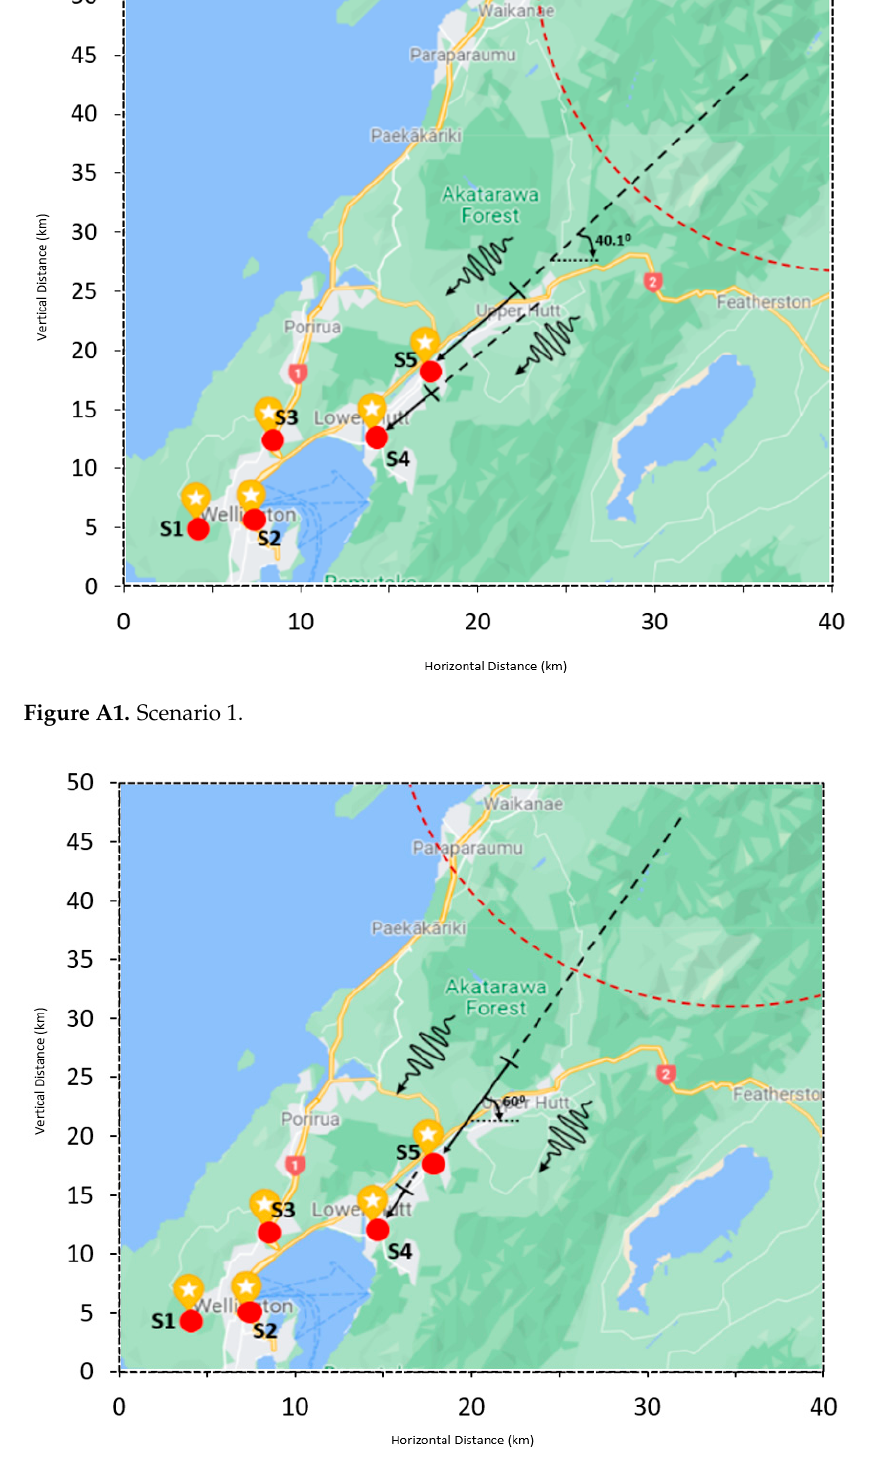
Figure A2. Scenario 2.